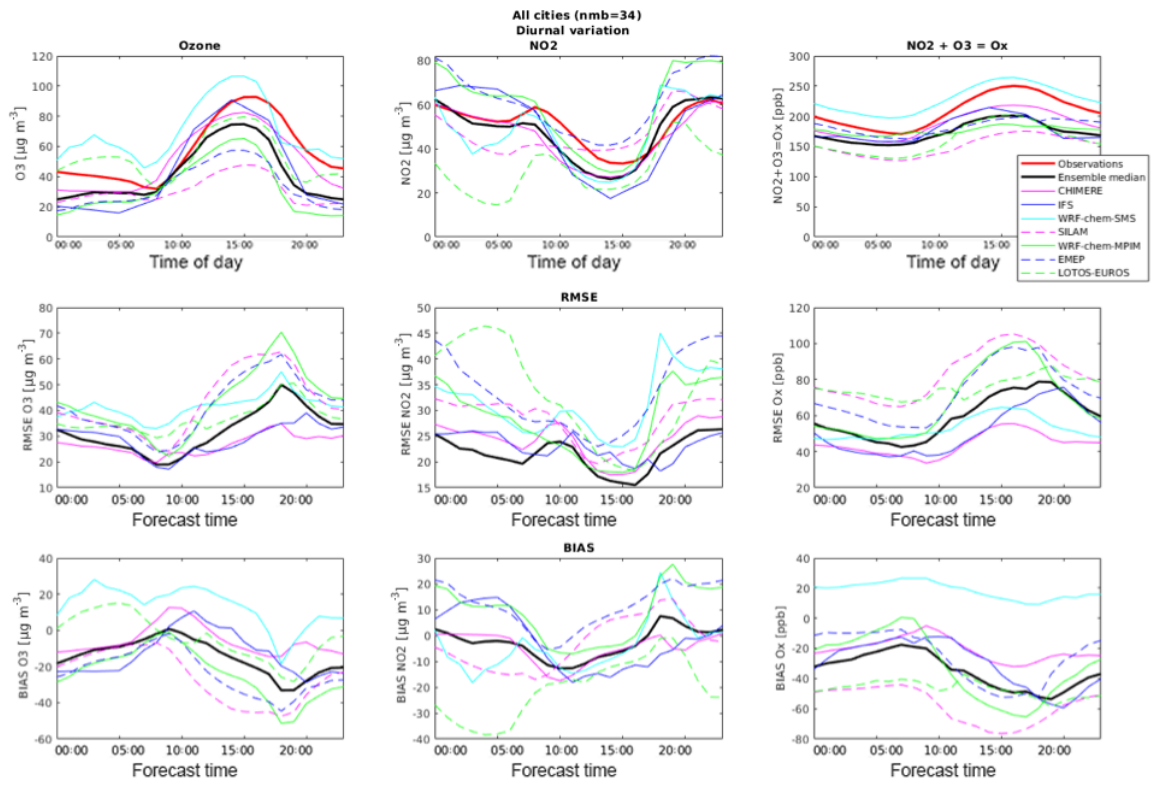
Figure 10. Upper row: diurnal variation in ozone (left), NO 2 (middle), and O x = NO 2 + O 3 (right) for the period 1–15 March 2017 for all cities included in the MarcoPolo–Panda Prediction system for all seven models and the ensemble median and the observations (red line). Middle row: root mean square error (RMSE) for ozone (left), NO 2 (middle), and O x (right). Lower row: bias for ozone (left), NO 2 (middle), and O x (right) for all models and for the ensemble median (black